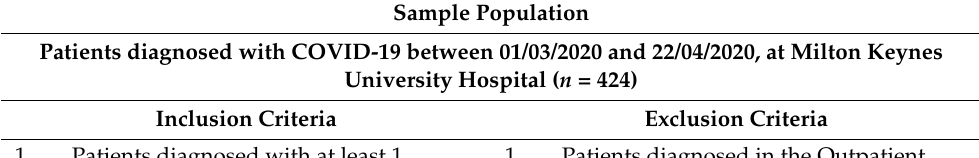
Table 1. Patient selection